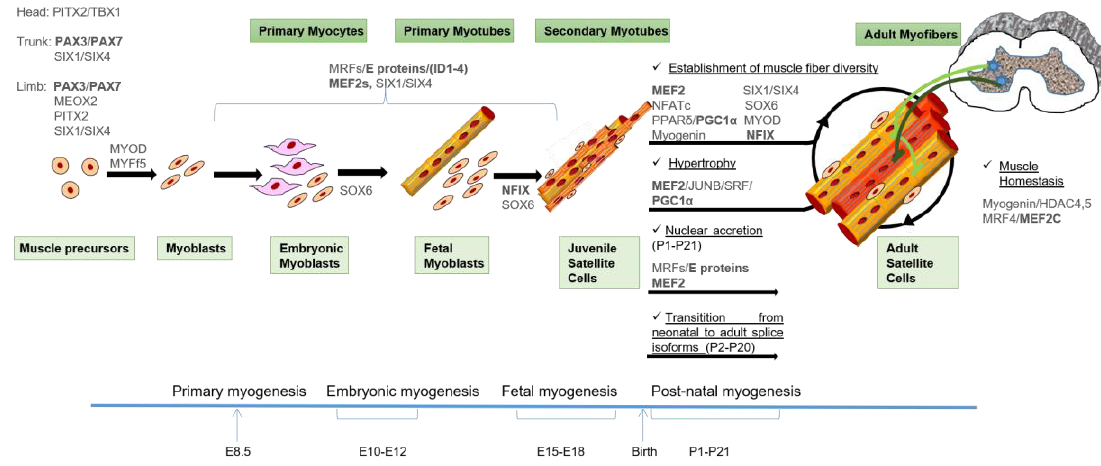
Figure 1. Model of skeletal muscle formation and the transcription factors (TFs) involved in the control of the different waves of myogenesis. MYF5+ cells from the somitic dermomyotome are the first muscle precursors that differentiate into the myocytes of the early myotome, which provides the basic scaffold on which skeletal muscle forms in the sequential waves of myogenesis. Subsequently, PAX3/PAX7 positive cells give rise to muscle precursors during development and post-natal muscle growth: embryonic and fetal myoblasts give rise to embryonic and fetal myofibers, respectively. Satellite cells (SC) appear at the end of gestation and are responsible for postnatal growth (juvenile SC) and regeneration (adult SC). Extraocular and first branchial arch-derived myogenic progenitors are regulated by distinct gene regulatory networks where the bicoid-related Paired Like Homeodomain 2 (PITX2) and the T-box factor TBX1 TFs play a primary role. Independently of their origin, muscle differentiation of precursors depends on the activities of Muscle Regulatory Factors (MRFs) and their co-activators, the ubiquitous E proteins and the Myocyte Enhancer Factor 2 (MEF2) proteins. The fetal-specific gene expression program also involves the activity of Nuclear Factor I/X (NFIX). Post-natal muscle maturation is the result of several different processes including muscle growth (nuclear accretion and protein synthesis), fiber type specification induced by innervation and transition from embryonic to adult splicing isoforms of contractile and metabolic enzymes isoforms. The main TFs involved in the control of these processes are indicated, and the TFs that undergo alternative splicing are underlined in bold. A detailed description of the TFs networks can be found in the text. An indicative timing of murine development is depicted.